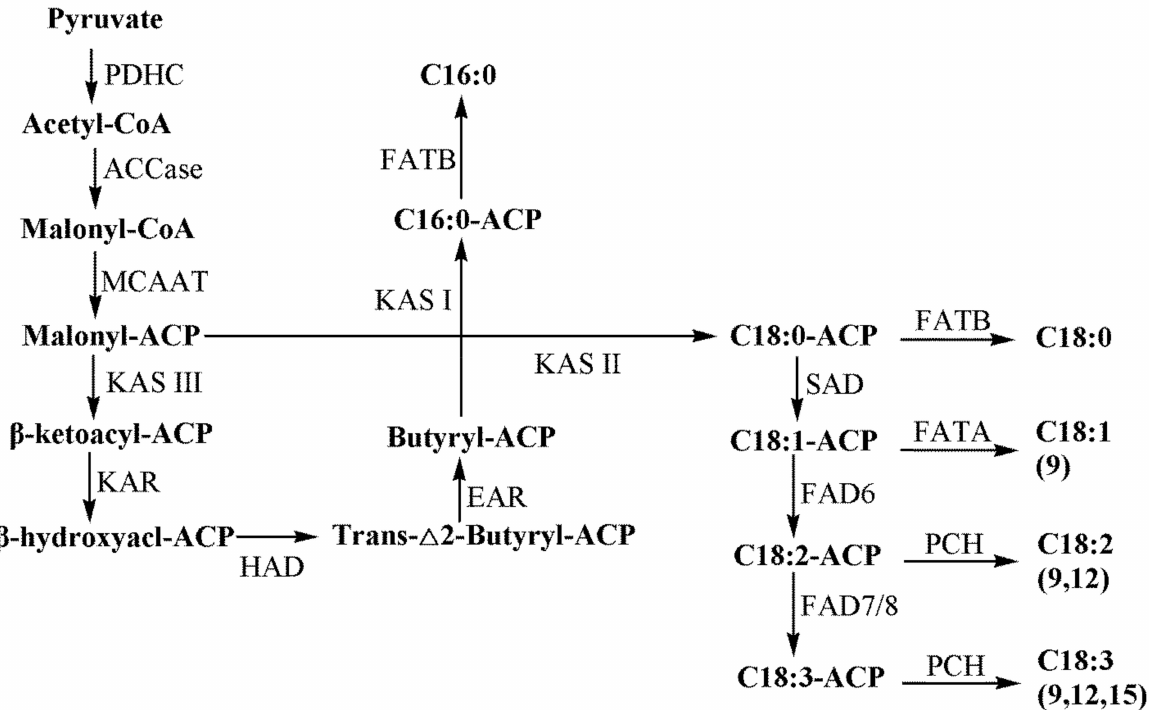
Figure 2. Proposed fatty acid biosynthetic pathway in C. sativa [20]. PDHC: pyruvate dehydrogenase com- plex; ACCase: acetyl-CoA carboxylase; MCAAT: malonyl-CoA: ACP transacylase; KAS: β -ketoacyl-ACP synthase; KAR: β -ketoacyl-ACP reductase; HAD: hydroxyacyl-ACP dehydrase; EAR: enoyl-ACP reductase; SAD: stearoyl-ACP desaturase; FAD6: oleate desaturase (chloroplast-type); FAD7/8: linoleate desaturase (chloroplast-type); FATA/B: acyl-ACP thioesterase A/B; PCH: palmitoyl-CoA